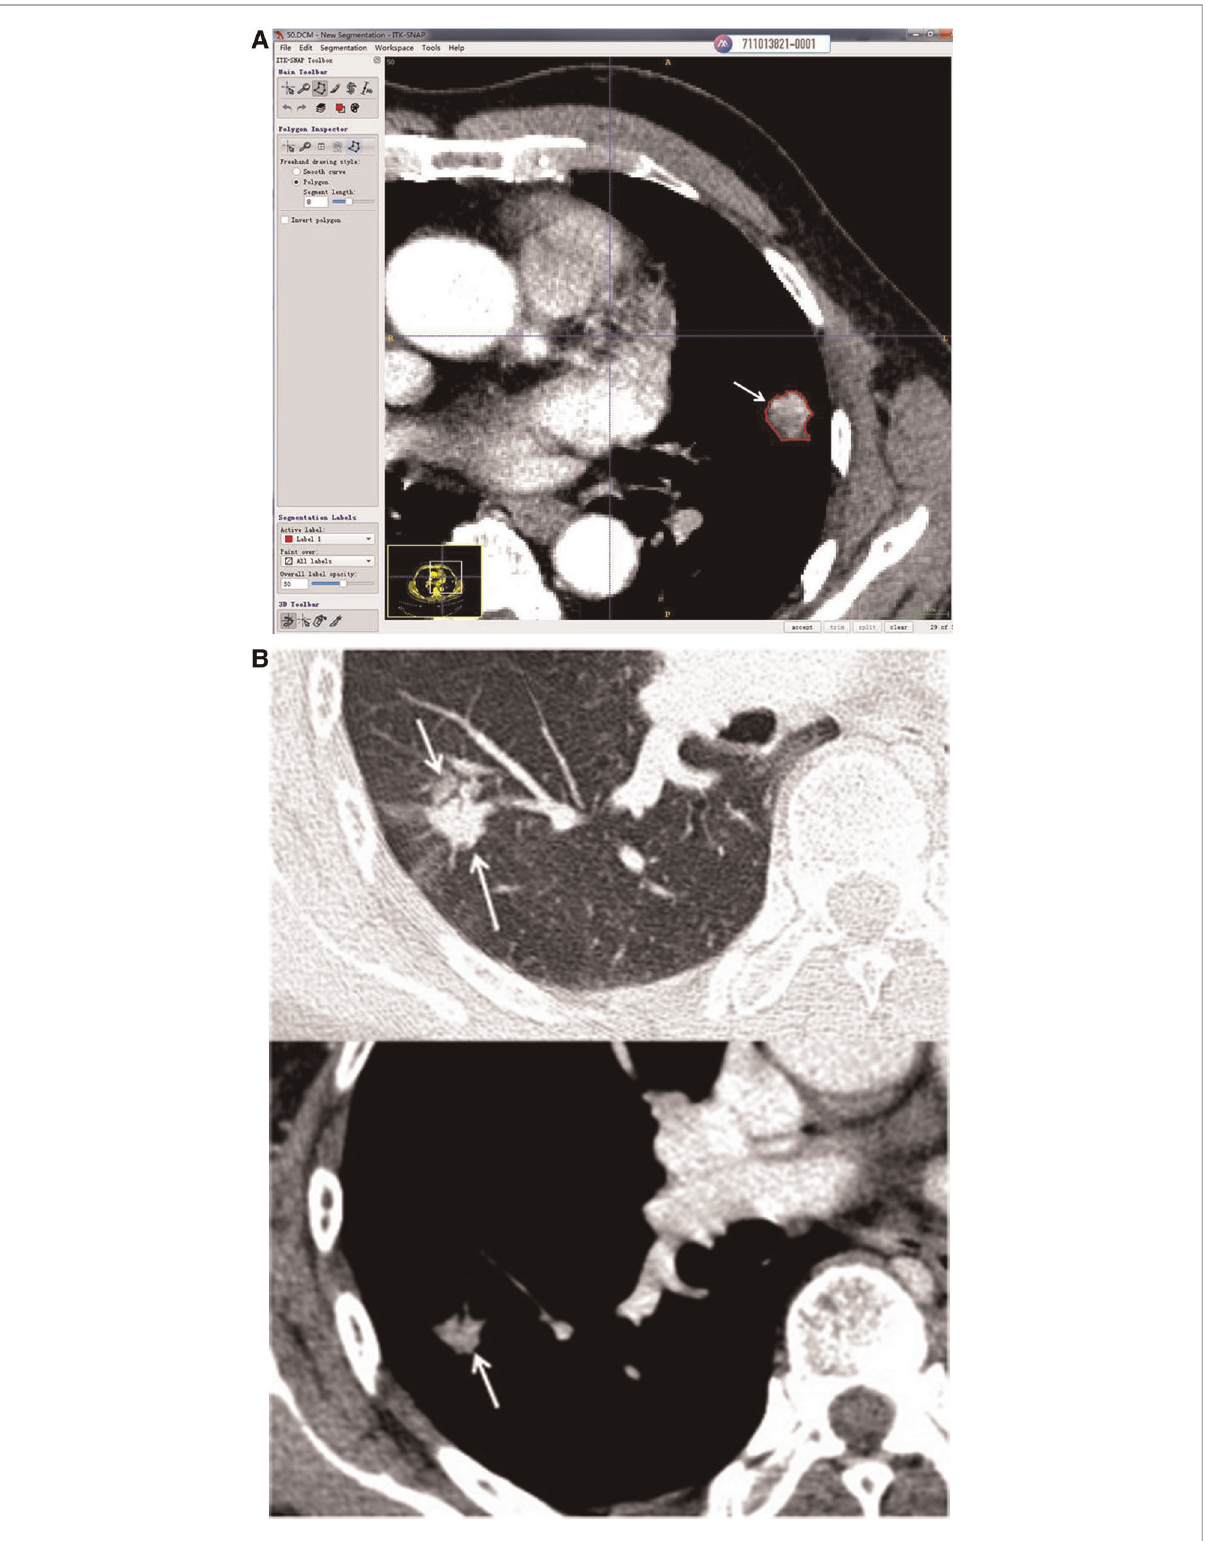
FIGURE 1 ( A )Useofthesnake-shapedsegmentationtoolofITK-SNAPsoftware(version3.8.1,www.itksnap.org)totracethecontourpro fi leofsolidtumorsinCTofthe mediastinalwindow.Thissolidnoduleoftheleftlungwasenhanced(venousphase,2 mmslicethickness)andcutalongthetumormargin(arrow).( B )Thispart solidnoduleoftherightlungwasenhanced(venousphase,2 mmslicethickness).Thenodepresentedpartgroundglassandpartsolidinlungwindowonup imaging (arrow).The solid partwere displayed in mediastinal window(arrow) and segmentation was done along the margin ofsolid part